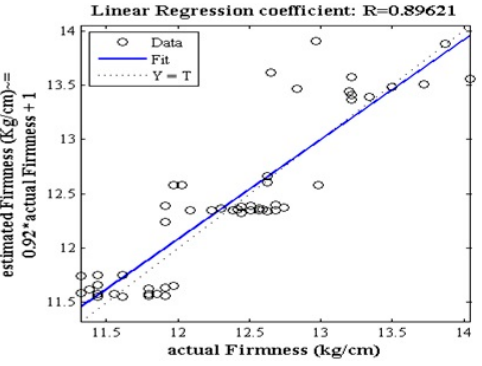
Figure 7. Regression analysis of the scatter plot between the estimated and the measured values of the apple firmness on the spectral range around the wavelength of 875 nm in the best training case.